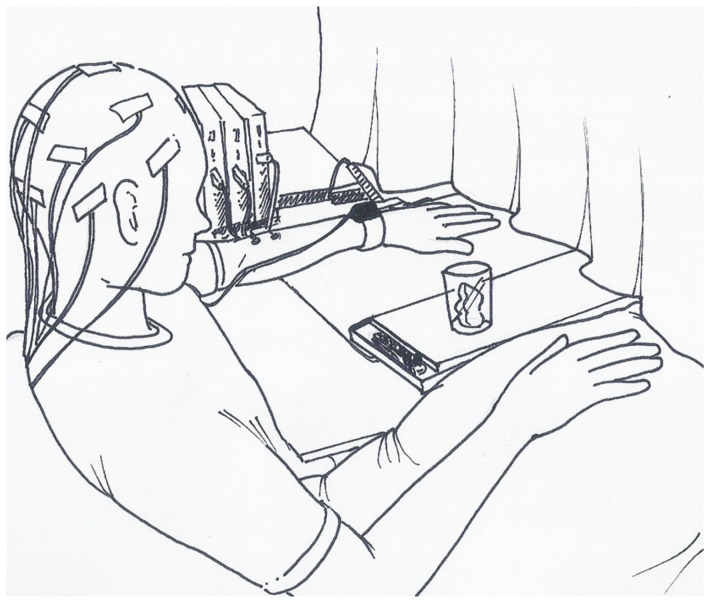
The participant sat with his left arm placed over a table.The right arm rested over a pillow for the duration of the session. An experimenter sat behind a black curtain and presented each cylinder fitted in a socket. Upon presentation, participants were instructed to wait, grasp the cylinder with the left hand and bring it close to the chest. Subjects were then asked to put the cylinder down on the tray socket and return the hand to the initial position. EEG and EMG signals were recorded throughout the experiment.